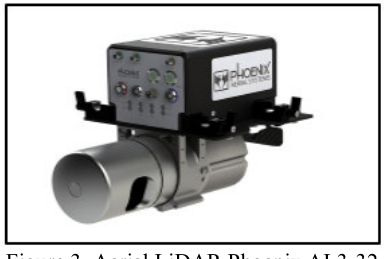
Figure 3. Aerial LiDAR Phoenix AL3-32. Sources: www.phoenixlidar.com